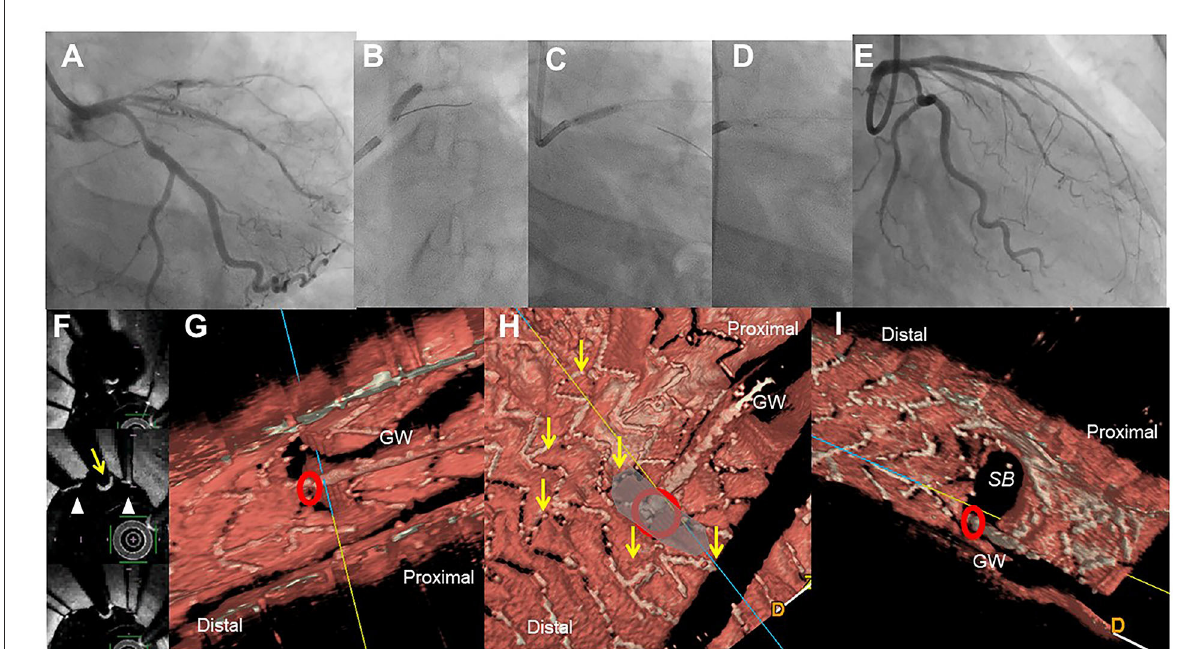
FIGURE2 Assessment of guide wire recrossing point in the ostium before side branch (SB) dilation in the provisional stenting. A 51-year-old woman with Medina 1-1-1 lesion in left anterior descending artery (LAD)-diagonal bifurcation (A) was treated with crossover stenting, 3.0/28mm Xience Alpine, (B) followed by proximal optimization technique (C) and SB dilation (D) , which resulted in acceptable results (E) (Supplementary Movie 3). Two-dimensional optical frequency domain imaging in the bifurcation ( F , top to bottom; pull back images from the distal) shows that the guidewire recrossed distally (yellow arrow) between the struts (triangles) at the carina. Three-dimensional vessel view (G) and carpet view (H) clearly demonstrates the guidewire recrossing point (red circle) with no link connection (yellow arrows) in the SB ostium. Final three-dimensional image shows wide opening of the SB without any jailing struts (I)